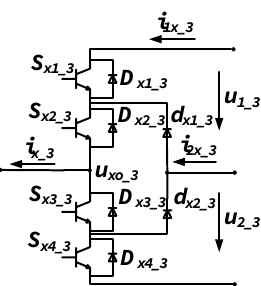
Figure 4. The topology of a single three-level arm.